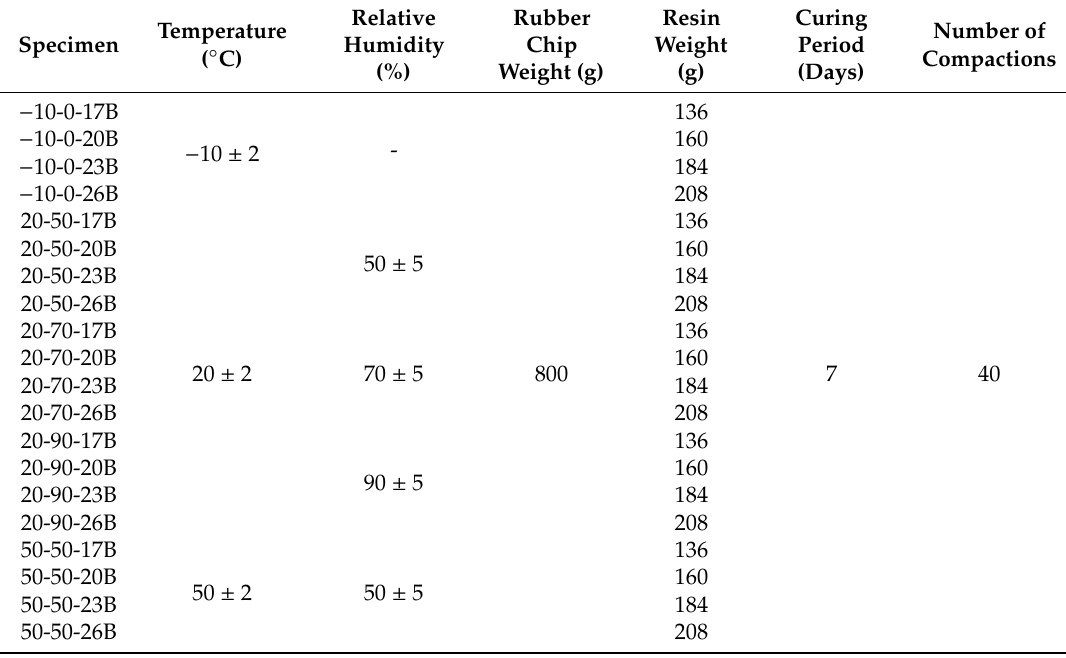
Table 3. Test variables applied to evaluate the e ff ects of the mixing ratio, temperature, and